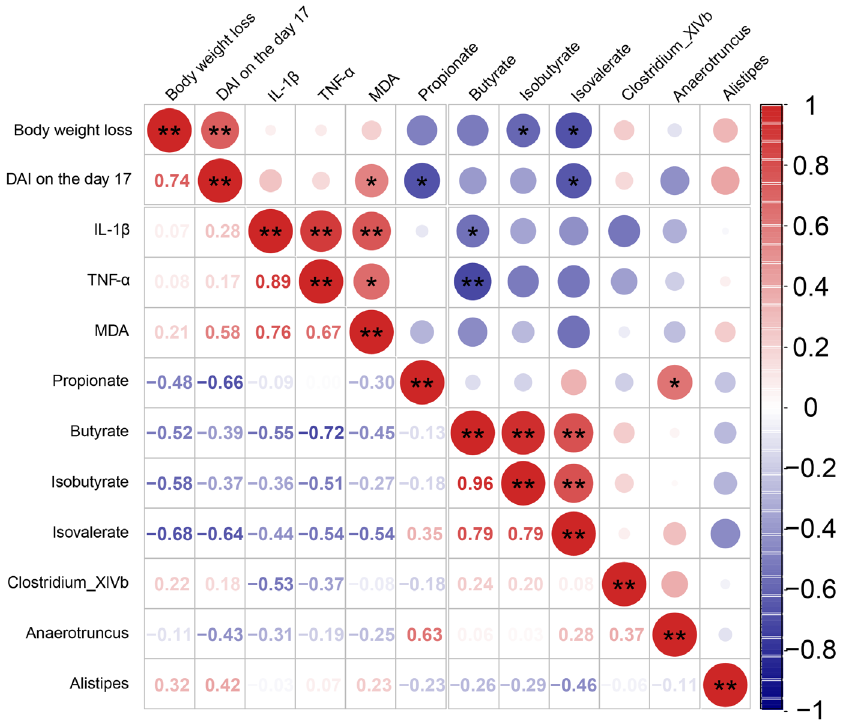
Figure 7. Correlation analysis among the DAI, fecal SCFAs levels, colon IL-1 β , TNF- α , and MDA levels, and gut microbiota. Spearman’s correlation analysis was performed. In the upper right corner, you could find the size and color of the circle used to represent the relevant indicator level, with red indicating positive and blue indicating negative. The corresponding value of the corresponding index could be found in the lower left corner. Correlation analysis among indicators,* p < 0.05, ** p < 0.01.